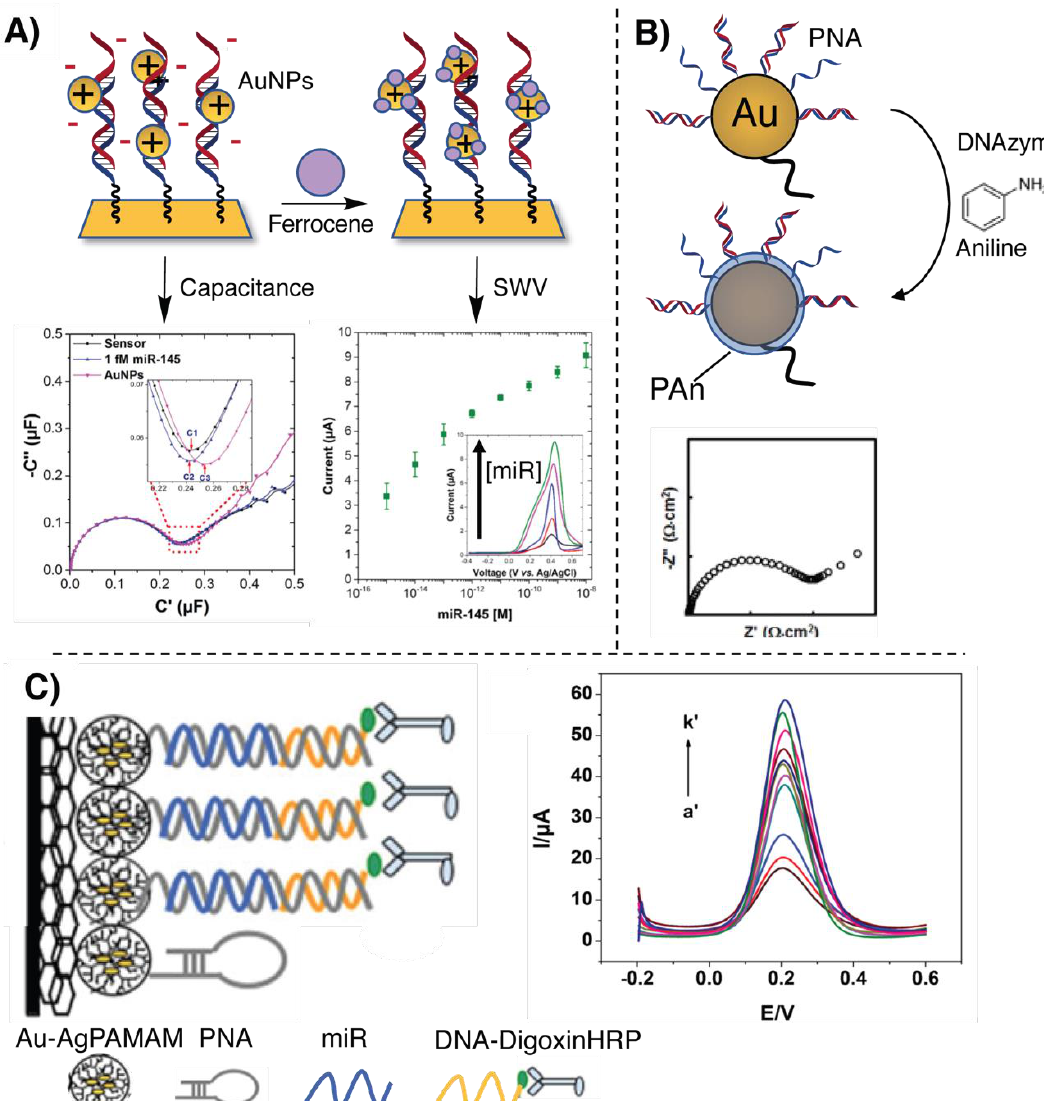
Figure 4. Illustration of the signal amplification and PNA-based electrochemical methodologies for miR detection. ( A ) Dual-mode detection of target miR-145, as presented in [71]. ( B ) Illustration of the miR-guided PAn biosensor proposed in [72] ( C ) Scheme of the biosensor described in [73].